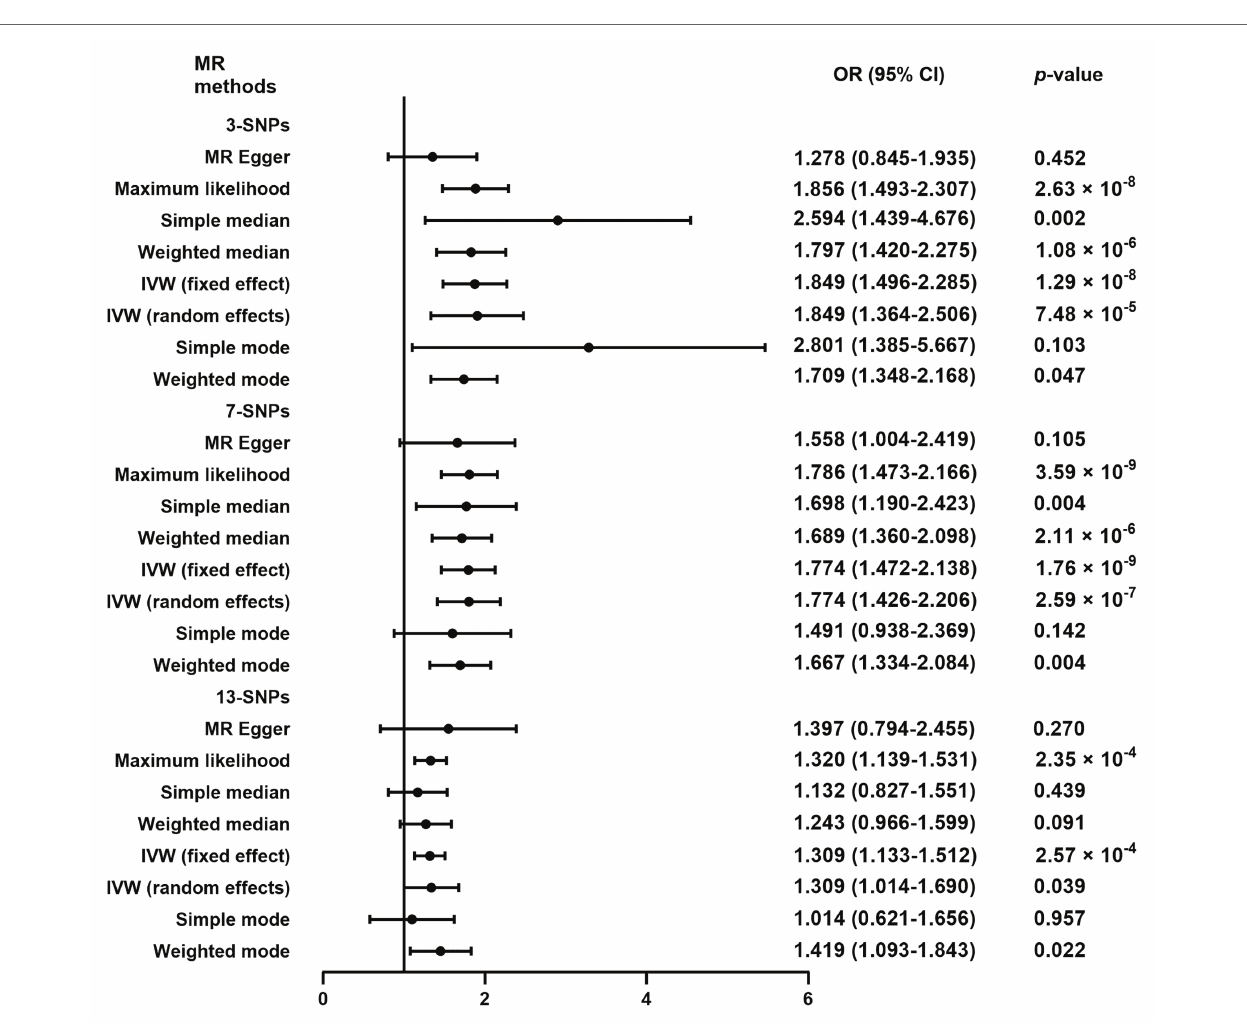
FIGURE 3 | Mendelian randomization analysis of plasma Hcy level on the risk of ischemic stroke caused by small artery occlusion. OR, odds ratio; CI, confidential interval; MR, Mendelian randomization; SNPs, single nucleotide polymorphisms; IVW, inverse variance-weighted. 3-SNPs: rs1801133, rs9369898, and rs548987. 7-SNPs: rs1801133, rs9369898, rs548987, rs4660306, rs2251468, rs838133, and rs12780845. 13-SNPs: rs1801133, rs9369898, rs548987, rs4660306, rs2251468, rs838133, rs12780845, rs2275565, rs7130284, rs154657, rs234709, rs42648, and